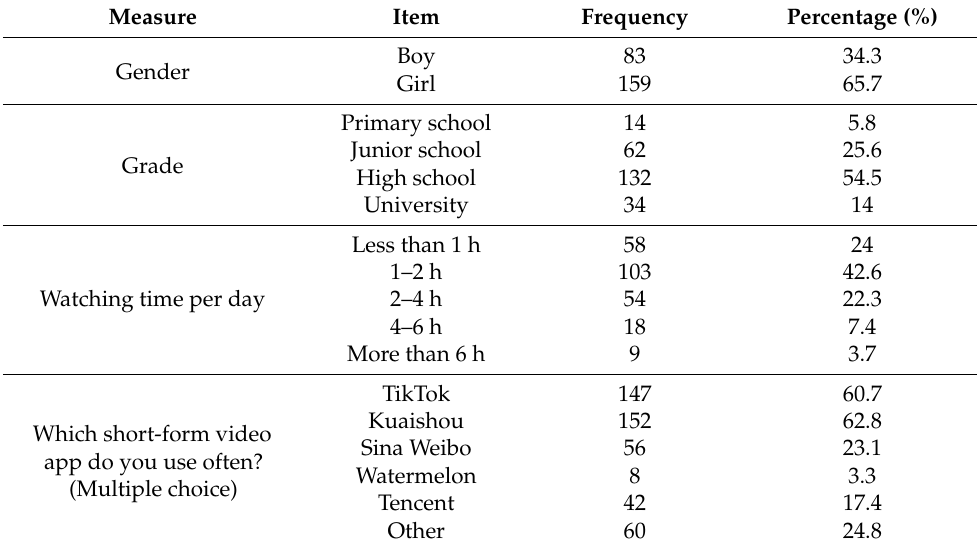
Table 1. Demographic characteristics of the participants ( n =